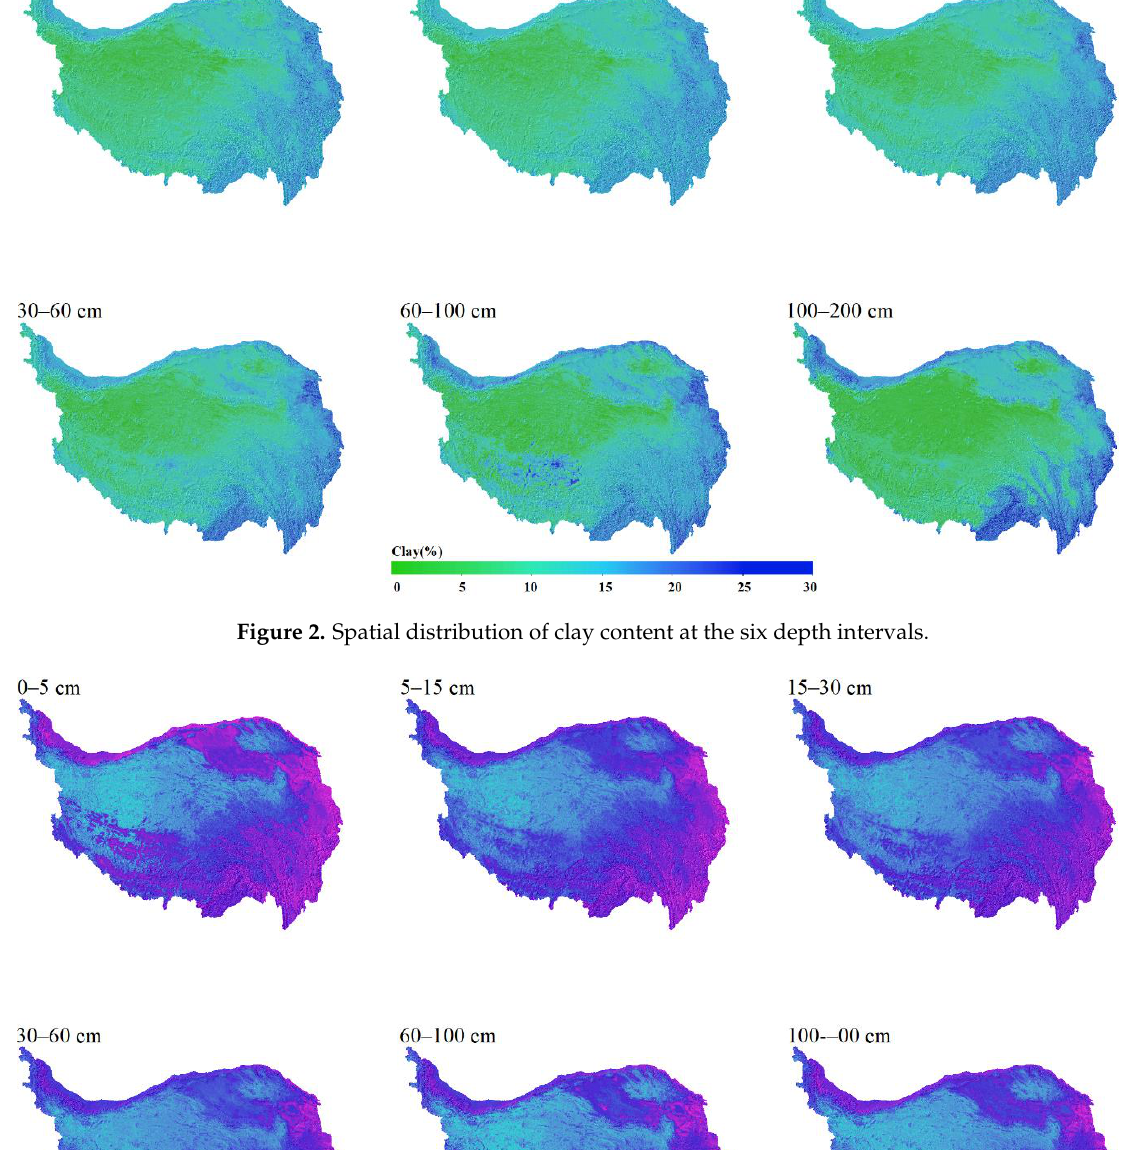
Figure 4. Spatial distribution of sand content at the six depth intervals. 3.4. Controlling Factors of QTP Soil Texture Patterns The importance of environmental factors for soil texture in each layer were also cal- culated by the RF algorithm. We listed the relative importance of the first 12 important variables at multiple depths (Figures 5 – 7). For the clay content in the soils, the most im- portant environmental factors affecting the spatial distribution of clay for the depth inter- vals within 0 – 60 cm were the annual mean temperature, channel network base level, and